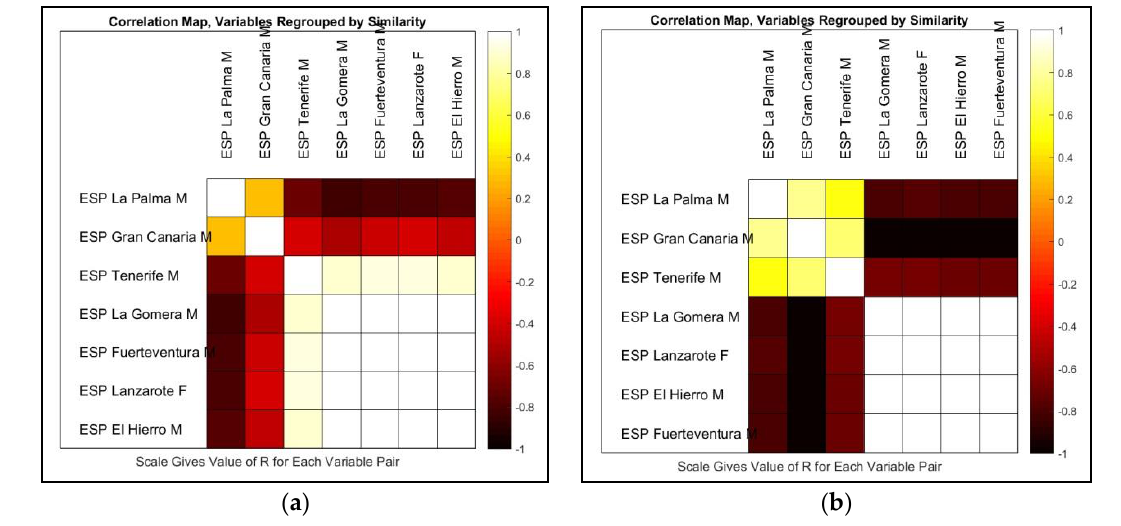
Figure 3. ( a ) Correlation matrix by survey areas for simple declarative sentences; ( b ) Correlation matrix for sentences with expansion in the object.